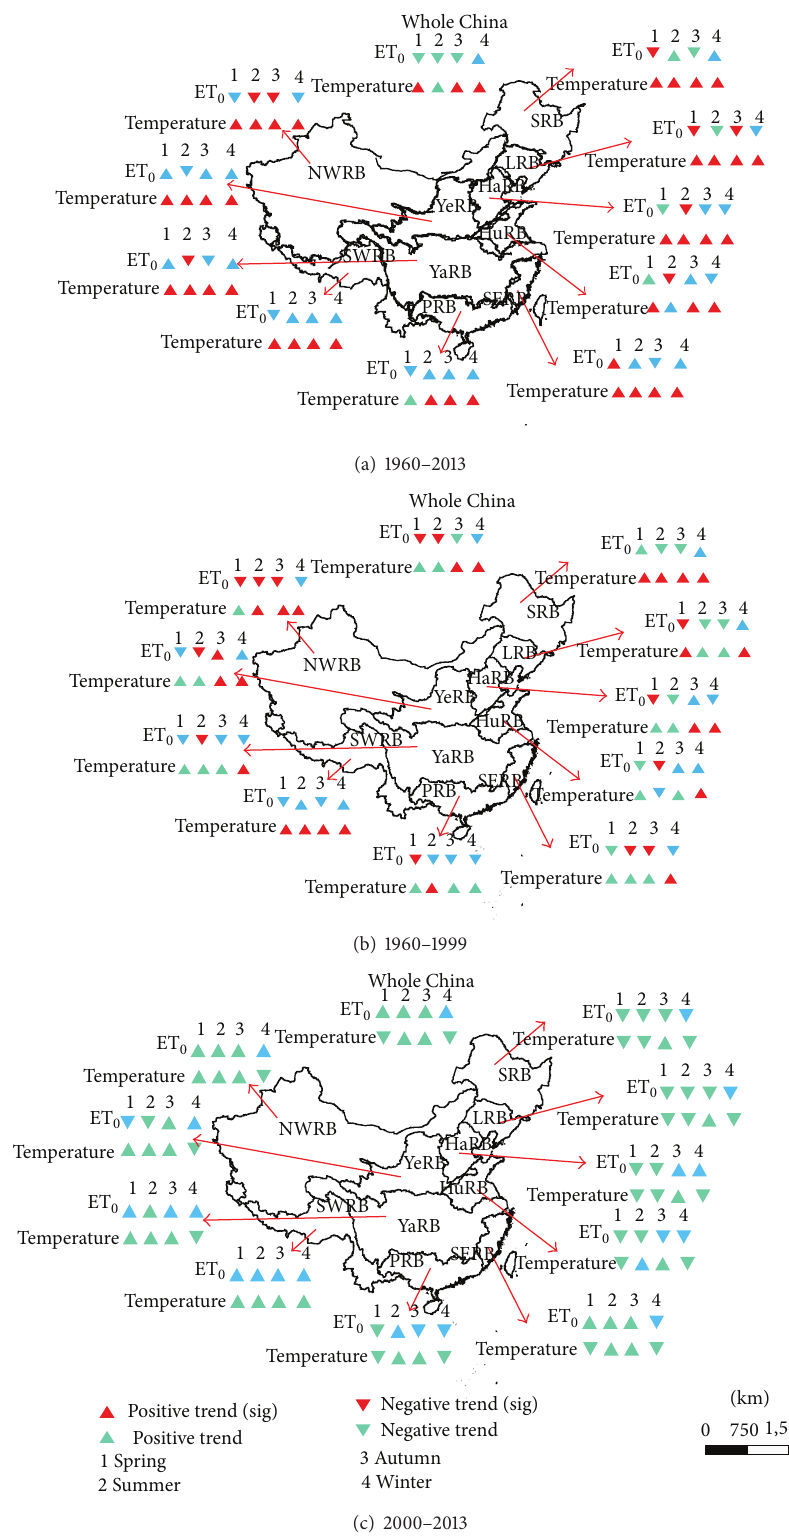
Figure 3: Seasonal change of temperature and ET 0 in different